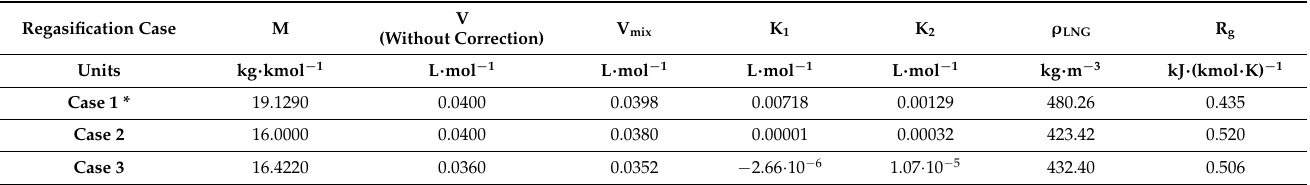
Table 2. Results of calculated physical properties of LNG for selected regasification